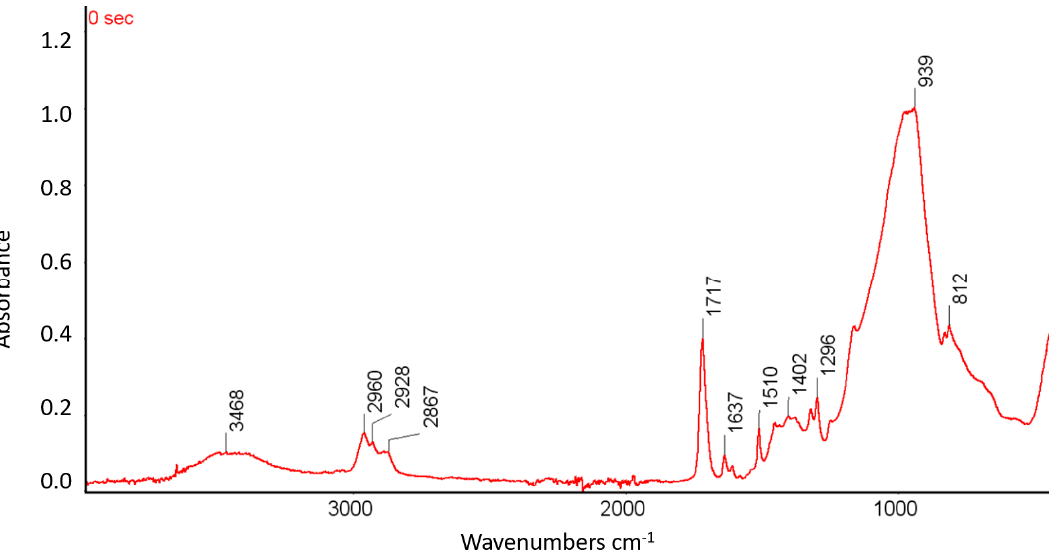
Figure 8. FTIR-ATR spectrum of the composite before irradiation with the denoted spectral bands.